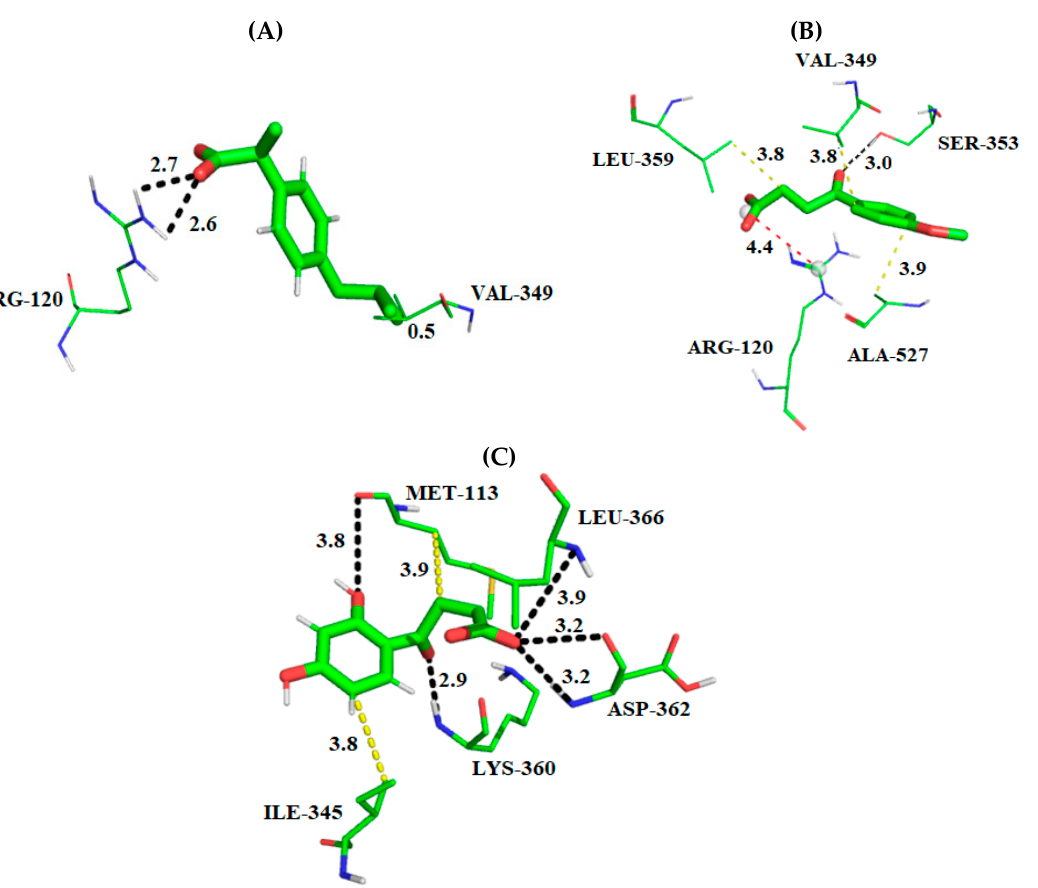
Figure 5. A root-mean-square fluctuation (RMSF) graph of COX-2 with compounds plotted in the XMGrace program .